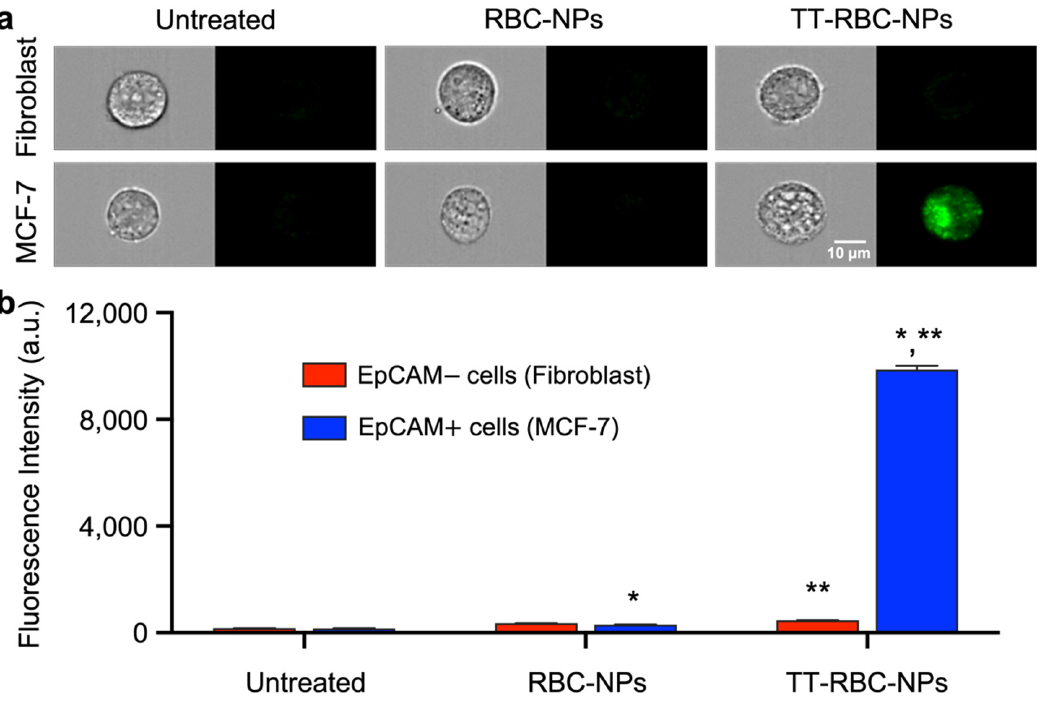
Figure 8. TT-RBC-NPs bind to MCF-7 (EpCAM+) cell. ( a ) Fluorescence images of MCF-7 (EpCAM+) and skin fibroblast (EpCAM–) cells treated with RBC-NPs (non-targeted NPs) and TT-RBC-NPs (targeted NPs). Images and fluorescent signals were measured by flow cytometer. The cancer cell morphology was imaged in bright field. All samples were labeled with FITC (green channel). Scale bar = 10 µm. ( b ) Quantification of mean fluorescence intensities of untreated, RBC-NPs and TT-RBC- NPs on skin fibroblast and MCF-7 cells. Bars represent mean ± SD ( n = 3). * the significance between RBC-NPs of EpCAM+ cells (MCF-7) and TT-RBC-NPs of EpCAM+ cells (MCF-7) ( p < 0.05). ** the significance between TT-RBC-NPs of EpCAM– cells (Fibroblast) and TT-RBC-NPs of EpCAM+ cells (MCF-7) ( p < 0.05).